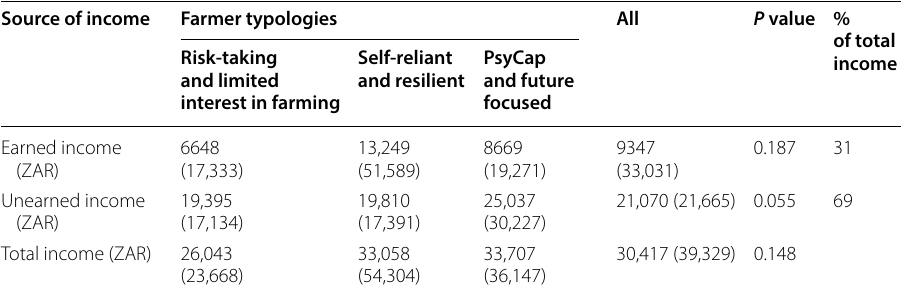
Table 3 Mean household income estimates for different farmer typologies. Source: